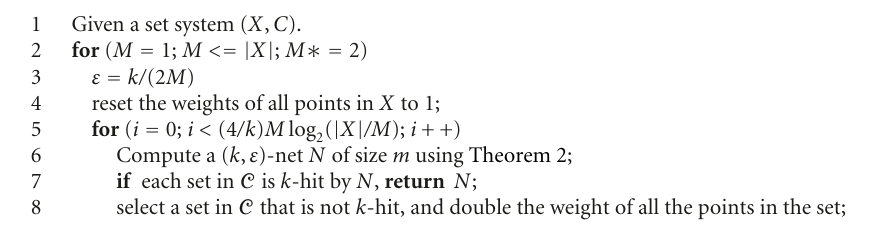
Algorithm 1: Solving k -HS problem using ( k , ε )-nets. Since k -HS is the dual of k -SC, this algorithm also solves k -SC (in k -SC, X corresponds to the set of sensors, and C to the set of target